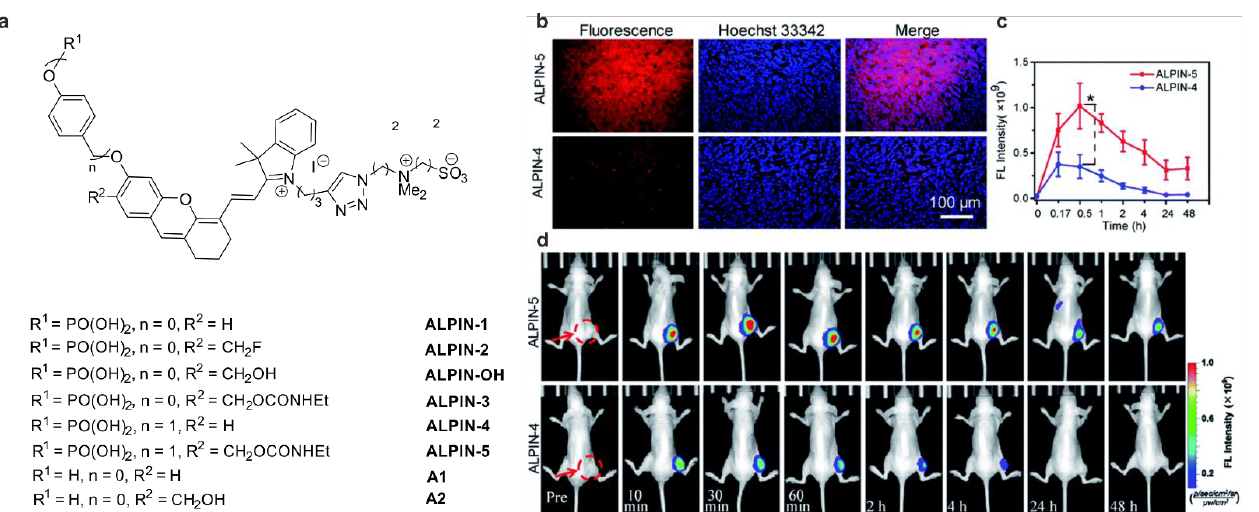
Figure 6. ( a ) Exact structures of the synthesized ALPIN dyes. ( b ) Fluorescent imaging of a tissue slice of a xenografted HeLa tumor in mice with immobilizing ALPIN-5 and non-immobilizing ALPIN-4 probes. ( c ) Fluorescent intensity of ALPIN-4 and ALPIN-5 after 48 h. ( d ) Imaging of ALP activity in mice in a 48 h time frame. Values are the mean ± SD (* p < 0.05, n = 3). The red arrows and circles indicate the tumor locations in the mice. Adapted from [40], used under CC BY-NC 3.0. The same group applied malachite green-based probes to monitor ALP activity [41].